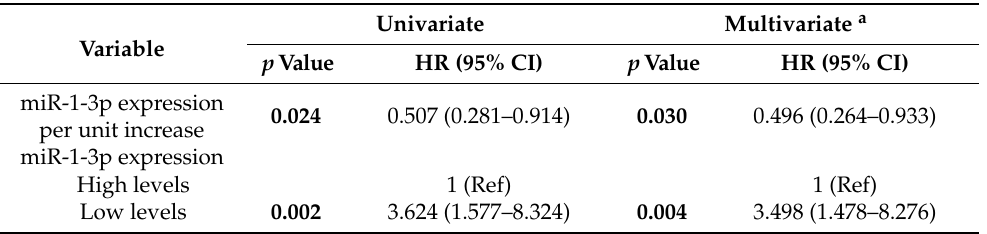
Table 4. Cox regression analysis for the association between miR-1-3p expression and postoperative mortality of AAA patients through 5-year